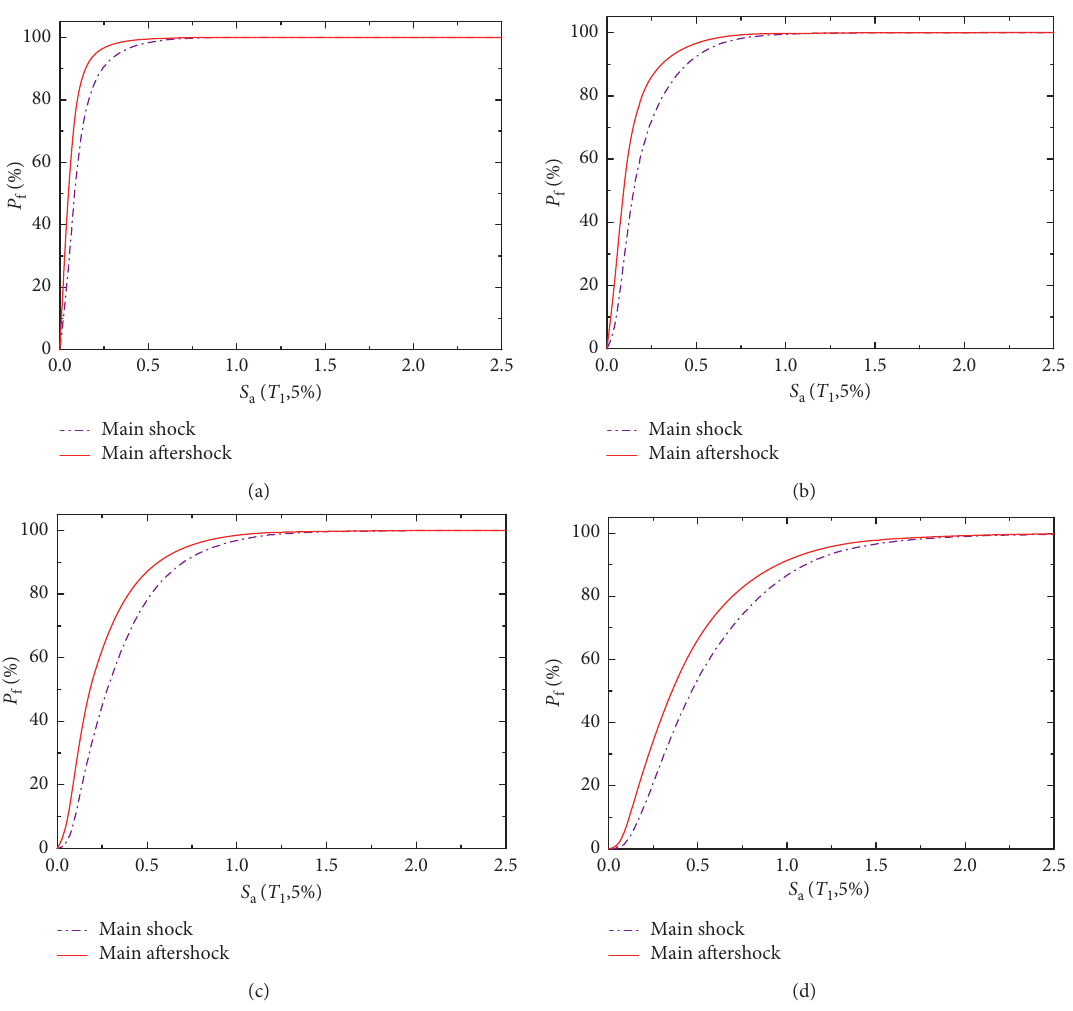
Figure 15: Vulnerability curves of various performance levels under two kinds of earthquakes. (a) LS